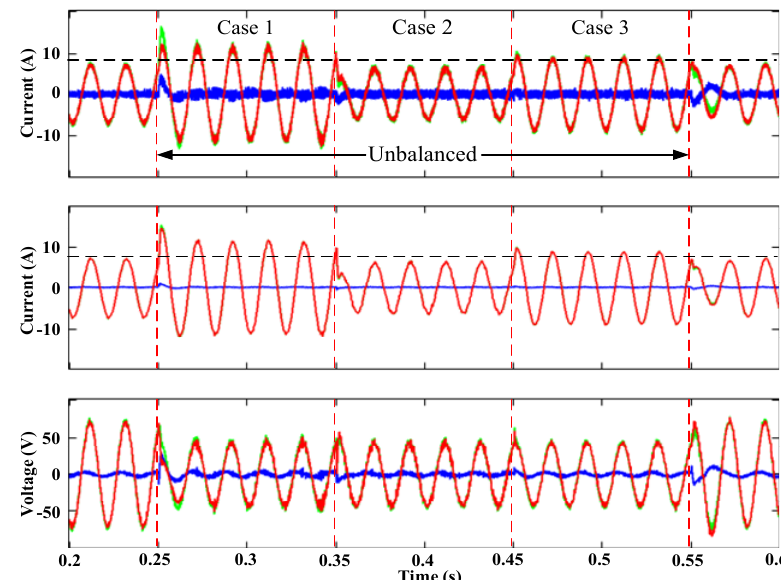
Figure 5. Simulated comparisons between measurements and estimations for the state variables in b-phase (red—measurements, green—estimations, blue—errors); top—inverter-side current; middle—grid-injected current; bottom—capacitor voltage.